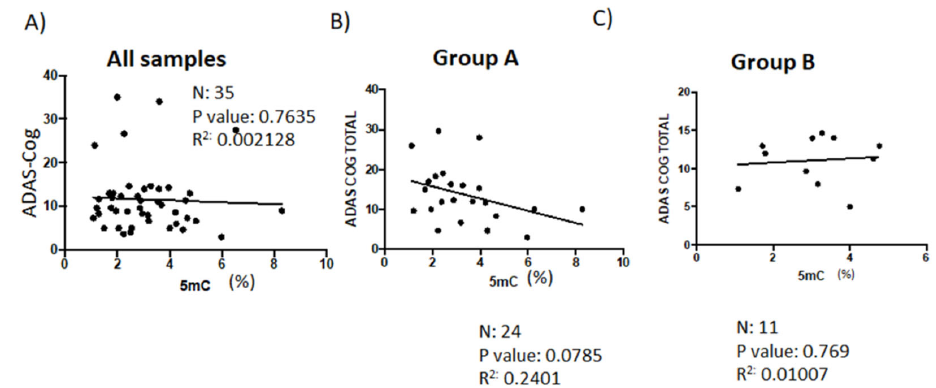
Figure 6. Correlation analyses of the relationship between patient ADAS ‐ Cog score and levels of global DNA methylation during clinical follow ‐ up. ( A ) The association between the total ADAS ‐ Cog scores and 5mC levels in all patients ( n = 35). ( B ) Correlation analysis to test the association between total ADAS ‐ Cog scores and 5mC levels in patients from Group A ( n =24), and ( C ) patients from Group B ( n =11). Data points indicate individual patient values. Pearson correlation was used to establish statistical correlation. 5mC, 5 ‐ methylcytosine; ADAS, Alzheimer’s Disease Assessment Scale; ADAS ‐ Cog, ADAS ‐ cognitive.